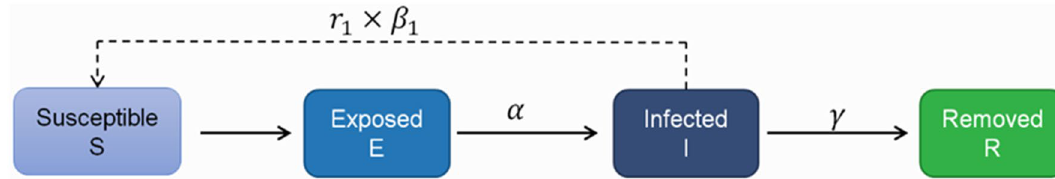
Figure 2. Schematic diagram of the traditional SEIR model.